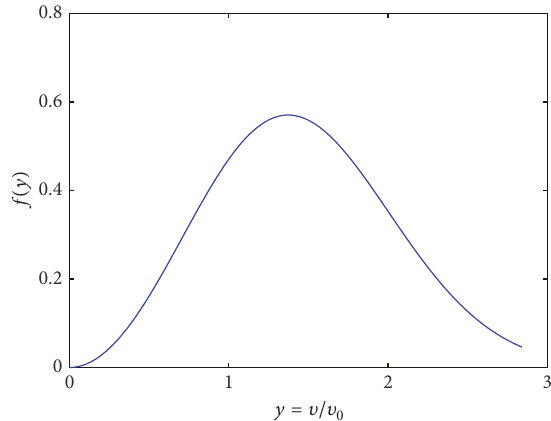
Figure 6: The shape of 𝑓(𝑦) for the decay of 3 H, where the atomic mass difference between 3 H and 3 He is taking Δ = 18.591 keV [69].